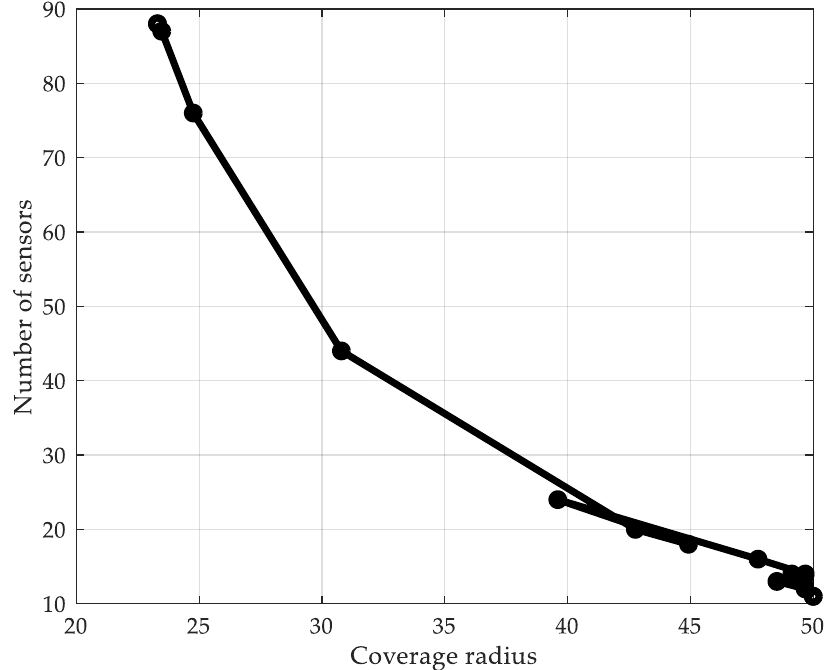
Figure 8. Number of sensors with coverage radius for territory coverage.